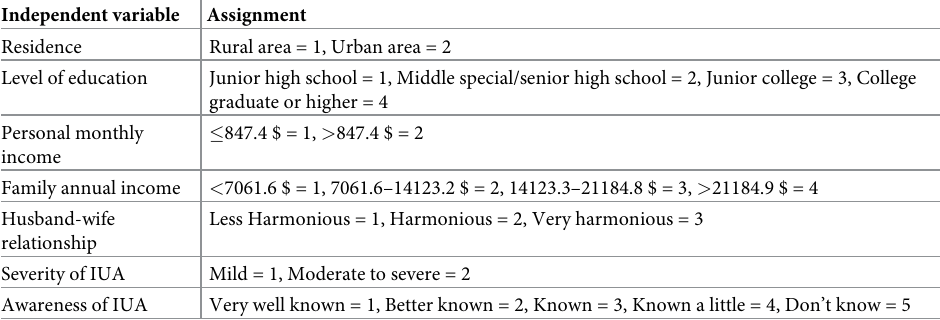
Table 3. Independent variable